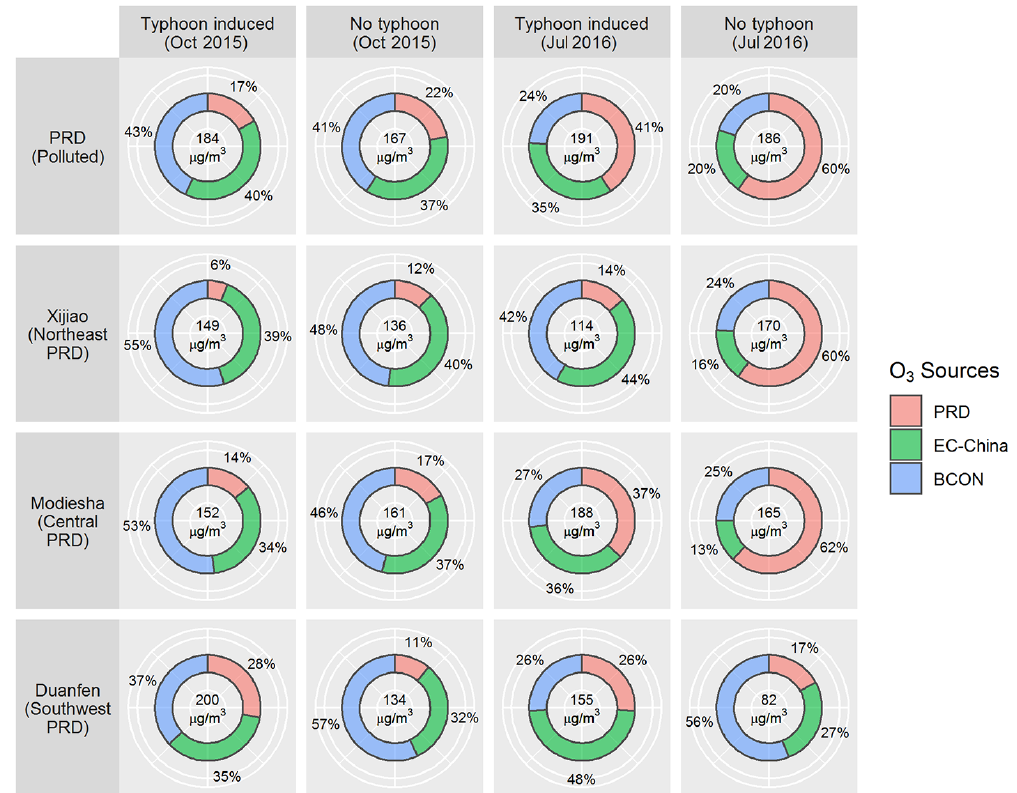
Figure 10. The mean O 3 SA near the ground (about 0–80m in height) on the represented typhoon-induced and no-typhoon O 3 pollution days in October 2015 and July 2016 (the average results of 09:00–17:00LT). The locations of the three representative sites (Xijiao, Modiesha and Duanfen) are shown in Fig. 8. PRD is the Pearl River Delta; EC-China is eastern and central China; BCON is the boundary condition of the d02 modelling.